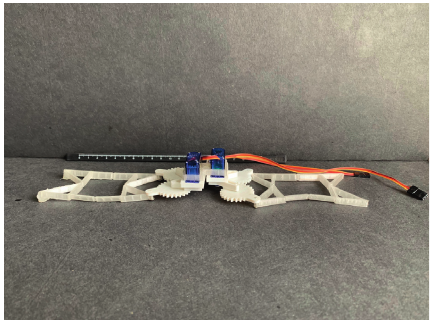
Figure 13: Bipedal soft